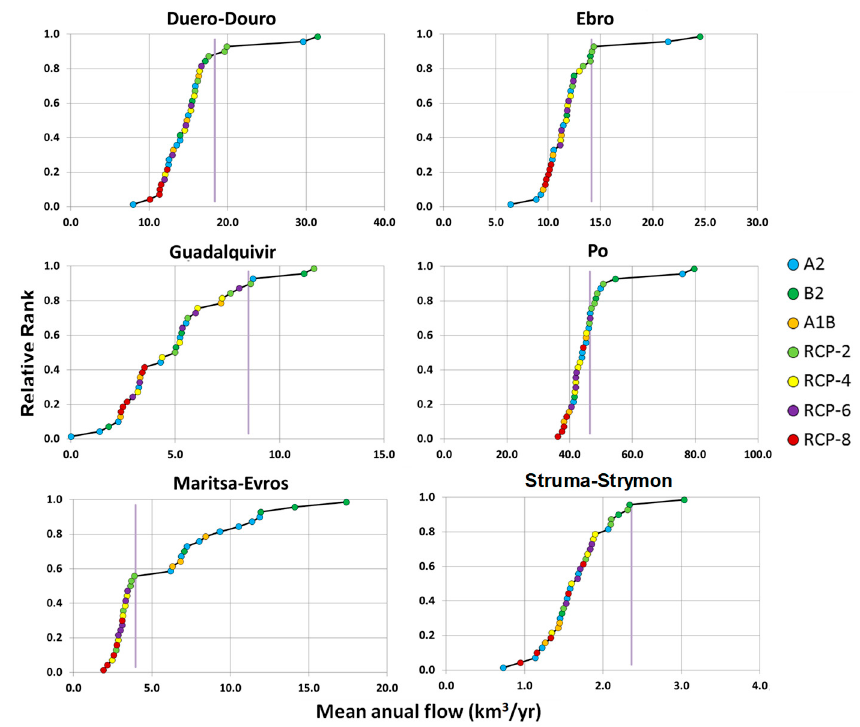
Figure 7. Mean annual flow (km 3 / yr) versus relative rank in the long-term projection (2070–2100, 35 model runs) in the basins under study. Mean annual flow (Global Runoff Data Center (GRDC)) in the historical period (1960–1990) is represented by the vertical purple line.